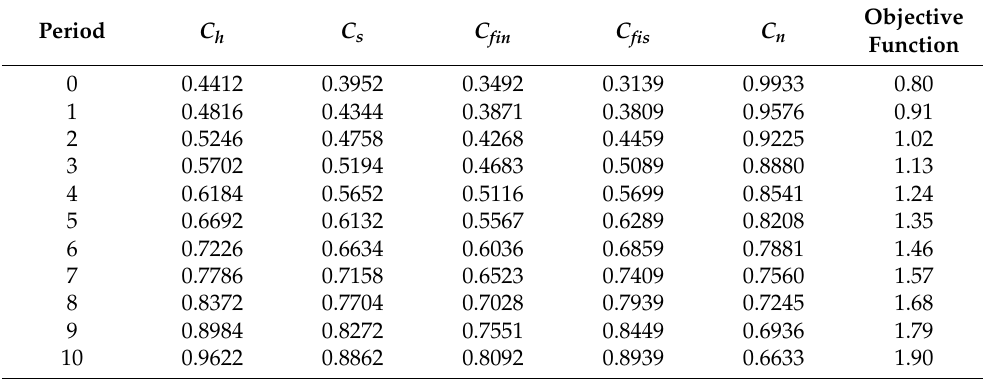
Table 4. Capitals evolution behavior between the different scenarios. Period C h C s C fin C fis C n